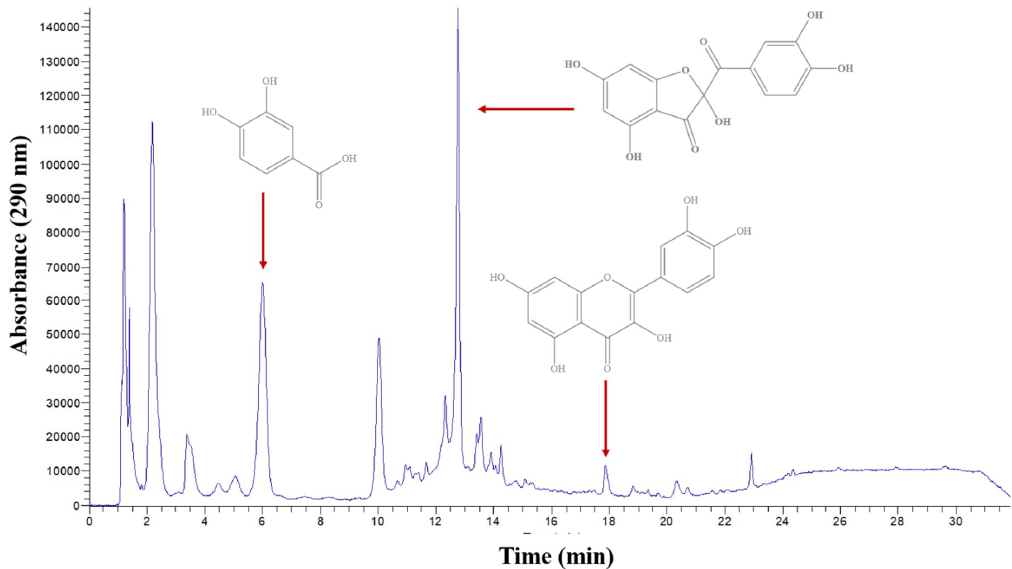
Figure 7. Chromatogram of sample #12 (see Table 2), monitored at 290 nm.